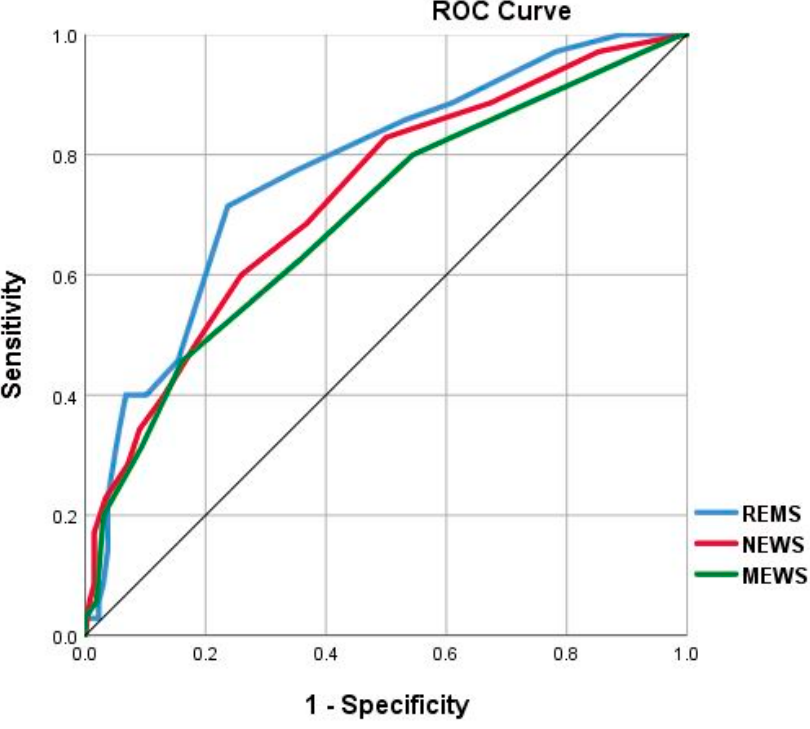
Figure 2. ROC curves for the early warning scores. Abbreviations: REMS: Rapid Emergency Medicine Score; NEWS: National Early Warning Score; MEWS: Modified Early Warning Score. Table 3. Discriminant ability of the REMS, NEWS, and MEWS for in-hospital mortality of COVID-19